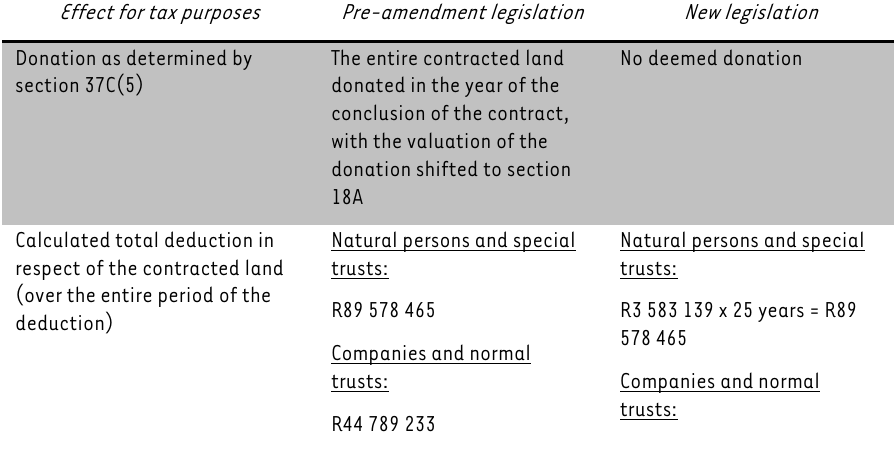
Comparison of the effect of pre-amendment and new legislation Effect for tax